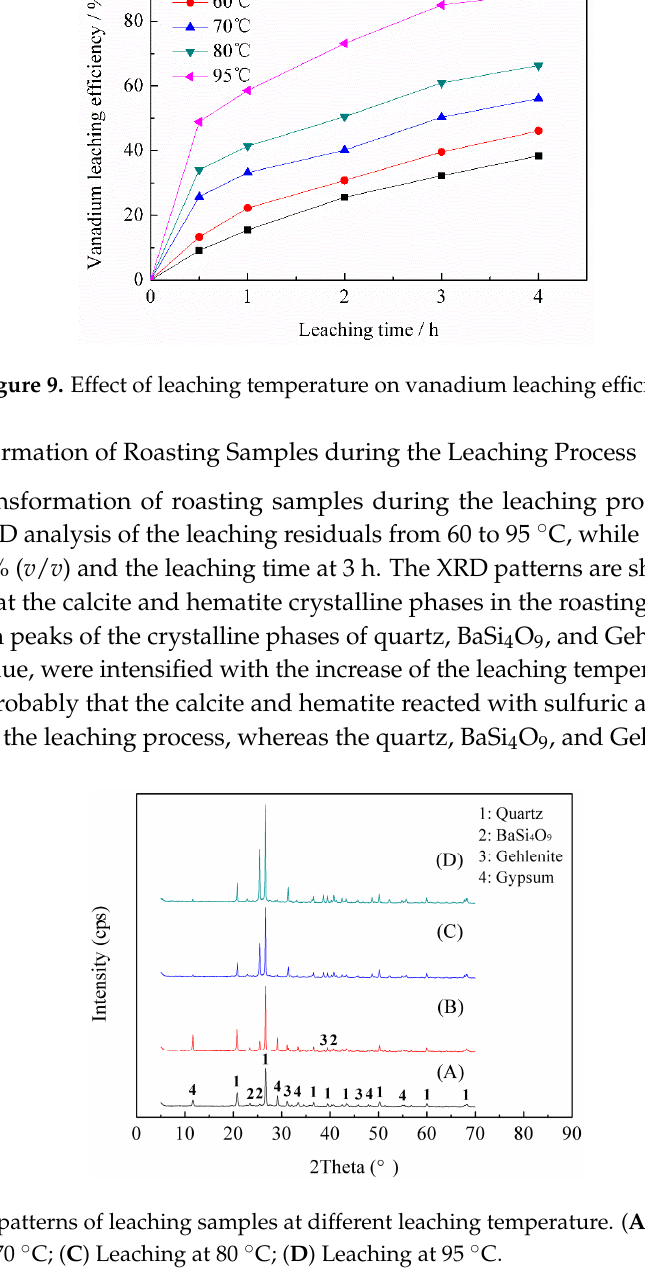
Figure 11. ( a ) BEI of leaching residual, EDS elemental distribution: ( b ) O; ( c ) Si; ( d ) V; ( e ) Ba; ( f ) Ca. 3.3. Kinetic Analysis Assuming that the particles are spherical, the reaction is irreversible and the loose ash layers could form after the reaction. The experimental data could be analyzed using the shrinking core model (SCM) [17]. The shrinking core model considers that the rate-controlling step of the leaching process is either the diffusion of the reactant through the solution boundary, or through a solid product layer, or the surface chemical reaction [18]. As the shrinking core model (SCM) is valid only for mono-sized particles, the practical way of doing the kinetic analysis is by limiting the particle size to a narrow size. Therefore, we divided the roasting sample into three particle size fractions: 0.038–0.044, 0.044–0.075, and 0.075–0.106 mm. The effect of particle size on the vanadium leaching efficiency is shown in Figure 12. It could be seen that the vanadium leaching efficiency increased with the decrease of the particle size. A shrinking core model (SCM) was utilized to analyze the experimental data (Figure 13). The linear relation